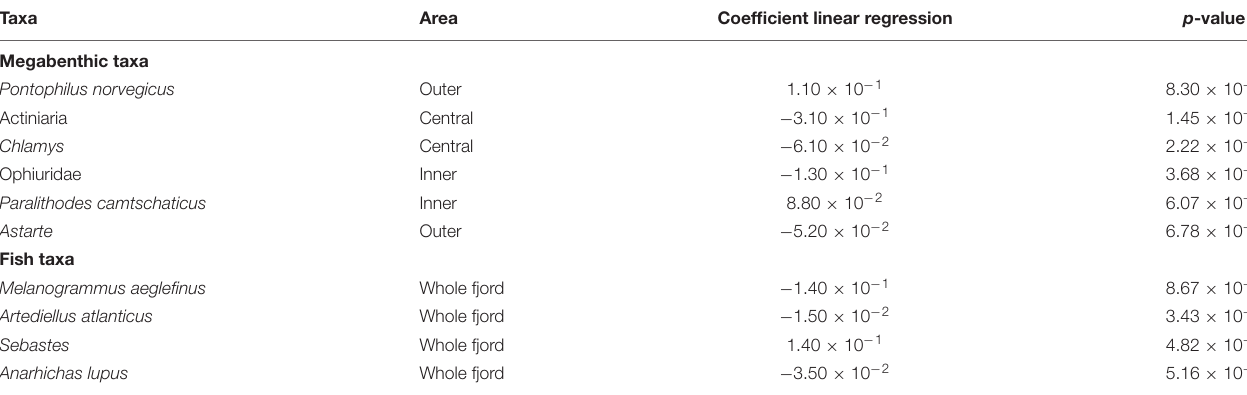
TABLE 1 | Coefficient and p -value of the linear regression of the log-transformed stratified biomass of megabenthic and fish taxa.